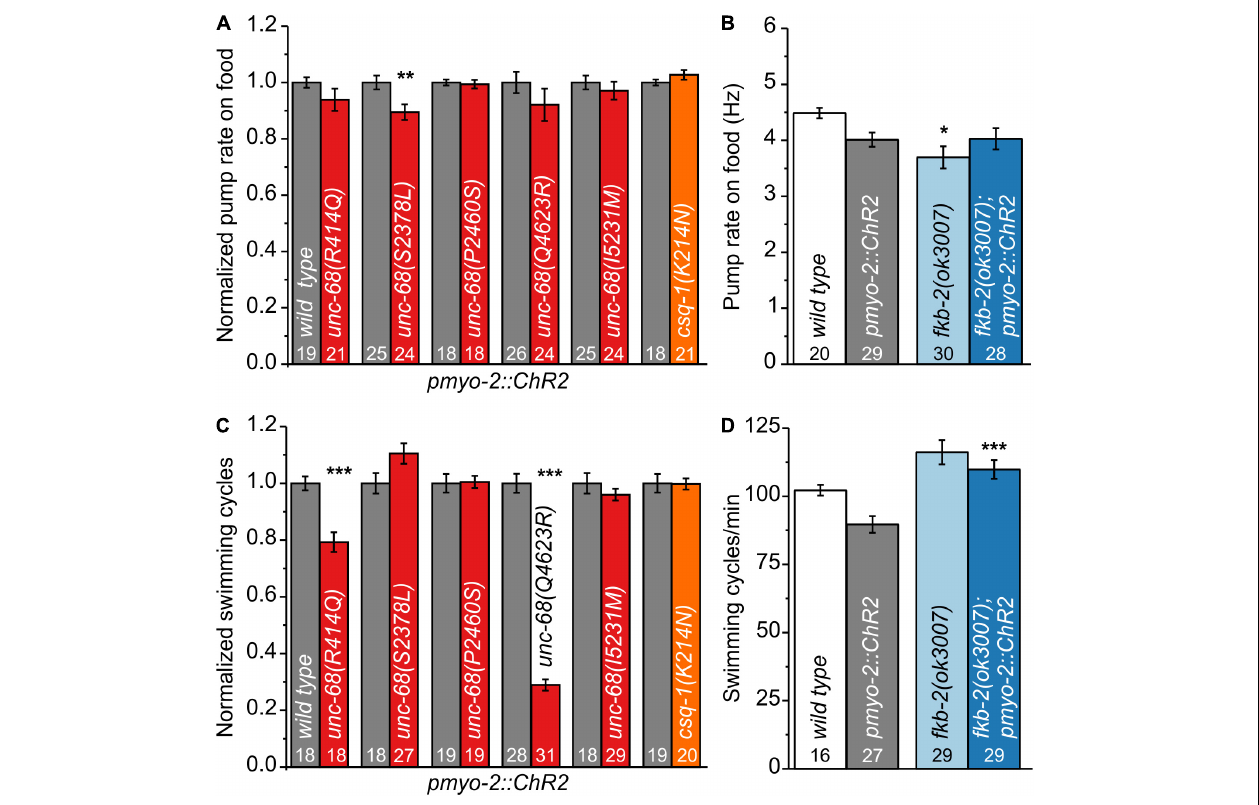
FIGURE 1 | Effect of catecholaminergic polymorphic ventricular tachycardia (CPVT) alleles and fkb-2 deletion on pharyngeal muscle cells (PMCs) and body-wall muscles (BWMs). (A) Unc-68(S2378L) shows a reduced normalized pump rate compared to the respective wild type (wt) control strain (young adult animals). (B) Deletion of fkb-2 [ fkb-2(ok3007 )] has no/minor effect on spontaneous pump rate on food. (C) Alleles R414Q and Q4623R show a reduction of normalized swimming cycles. (D) No significant effect of fkb-2 deletion on numbers of swimming cycles in comparison to the respective wild-type control. Whereas fkb-2 deletion in the pmyo-2::ChR2 background shows an increased number of swimming cycles in comparison to pmyo-2::ChR2 . Bar graphs display mean values ± SEM. One-way ANOVA with the Bonferroni post-hoc test (B,D) or two-sample t -test for the comparison of only two mean values (A,C) : * p ≤ 0.05, ** p ≤ 0.01, and *** p ≤